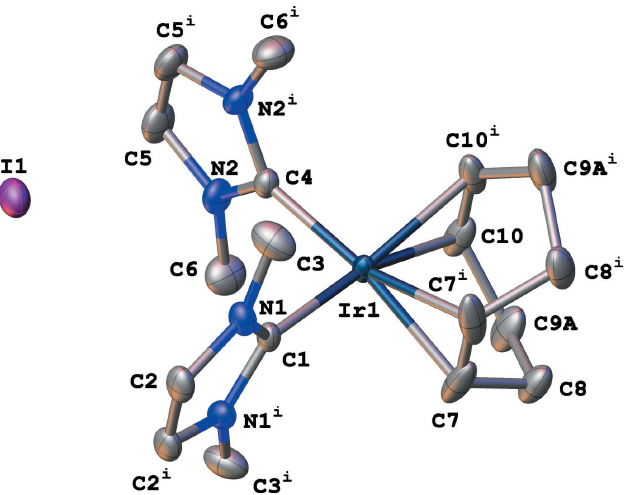
Figure 1 Displacement ellipsoid plot (50% probability) of ( (cid:2) 4